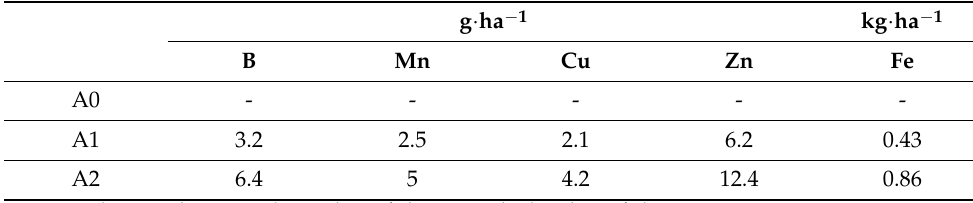
Table 1. Composition of the applied algae biomass doses.